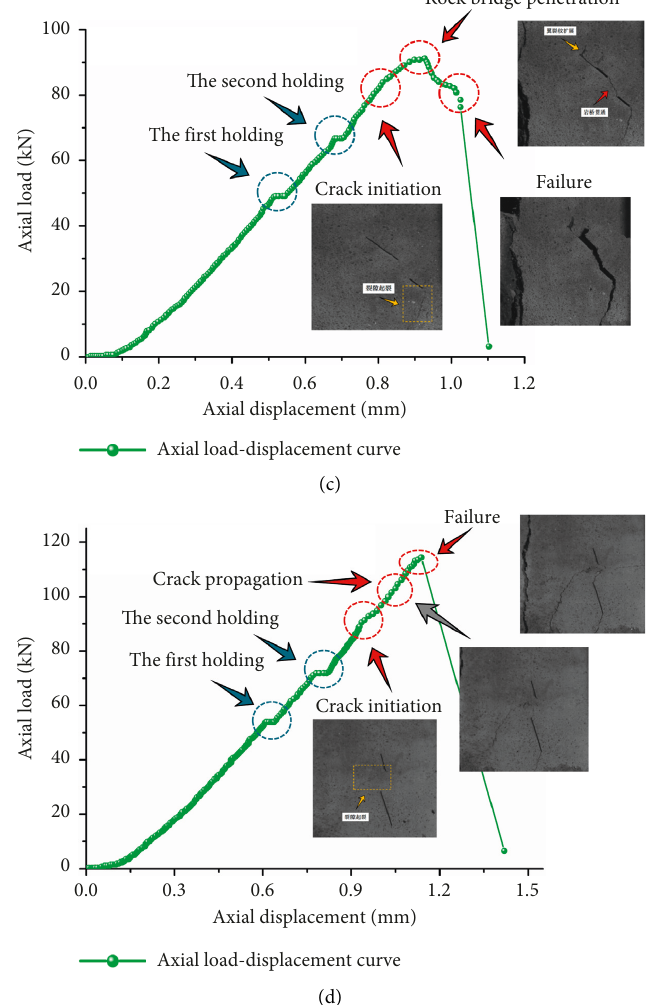
Figure 19: Axial load-displacement curves of specimens. (a) Specimen 1. (b) Specimen 3. (c) Specimen 4. (d) Specimen 6. Table 6: Geometric parameters of cracks in specimens. Specimen